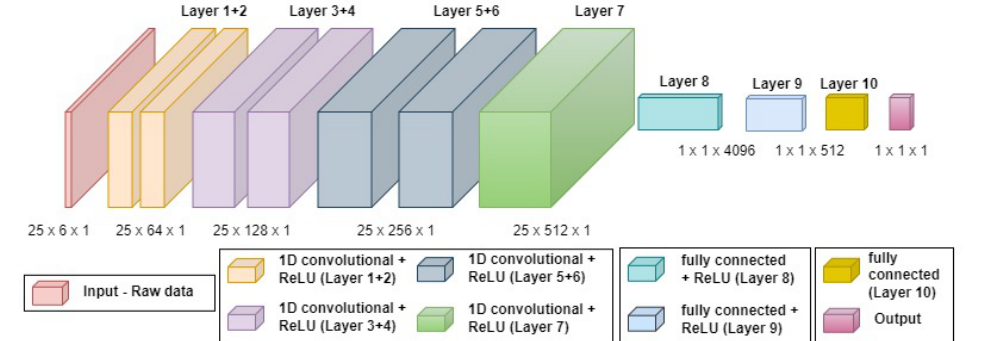
Figure 4. QuadNet1 architecture. QuadNet1 consists of 1D-CNN layers, used for feature extraction, and fully connected layers to output the change in distance or